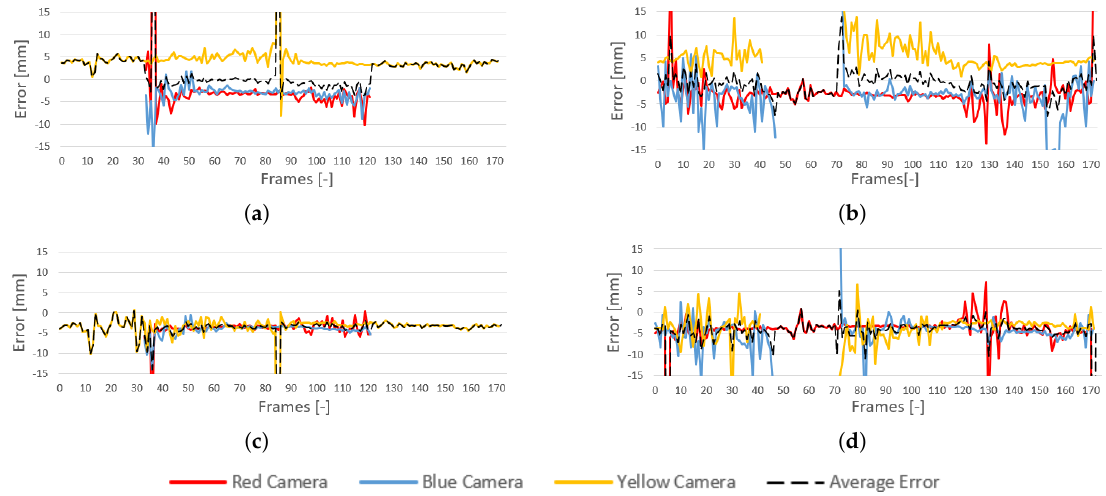
Figure 11. Error between detected and real position of the robots: ( a ) X direction of white robot; ( b ) X direction of black robot; ( c ) Y direction of white robot; ( d ) Y direction of black robot.